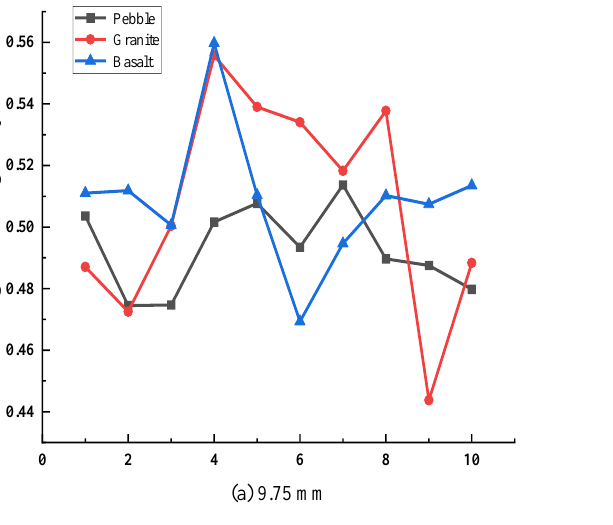
Figure 16. Change rate of angularity.